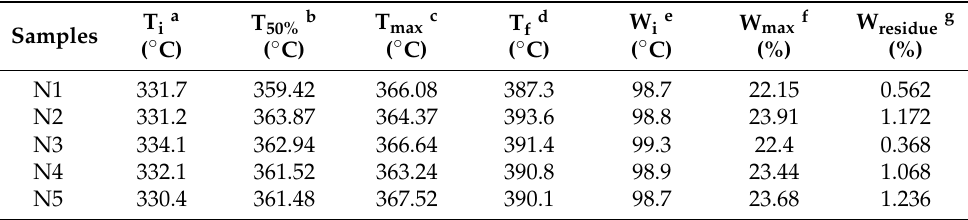
Table 2. TGA and DTG Results of PLA/PBS/CNC Composites.